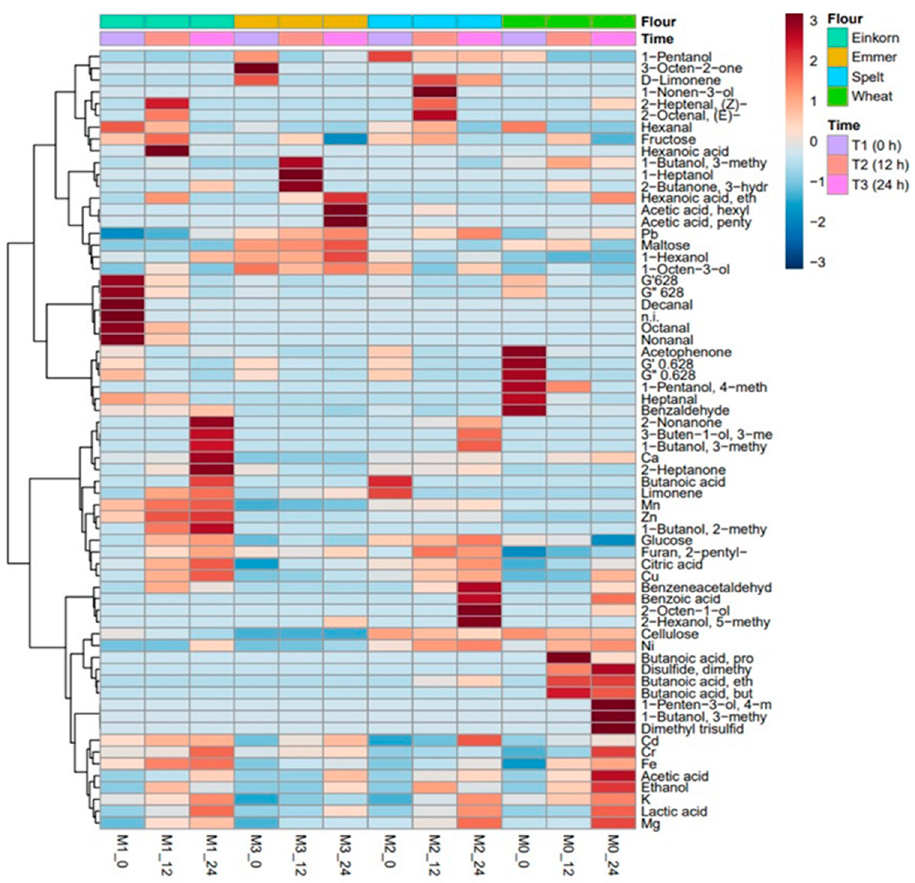
Figure 6. Heat map and HCA of the compounds and parameters identified in sourdough fermented for 0, 12, and 24 h with Lactiplantibacillus plantarum ATCC 8014. Where, the colors represent the compounds’ level, starting from light blue (low level) to white to dark red (high level). As indicated on the heatmap, three aldehydes, decanal, octanal, and nonanal were in